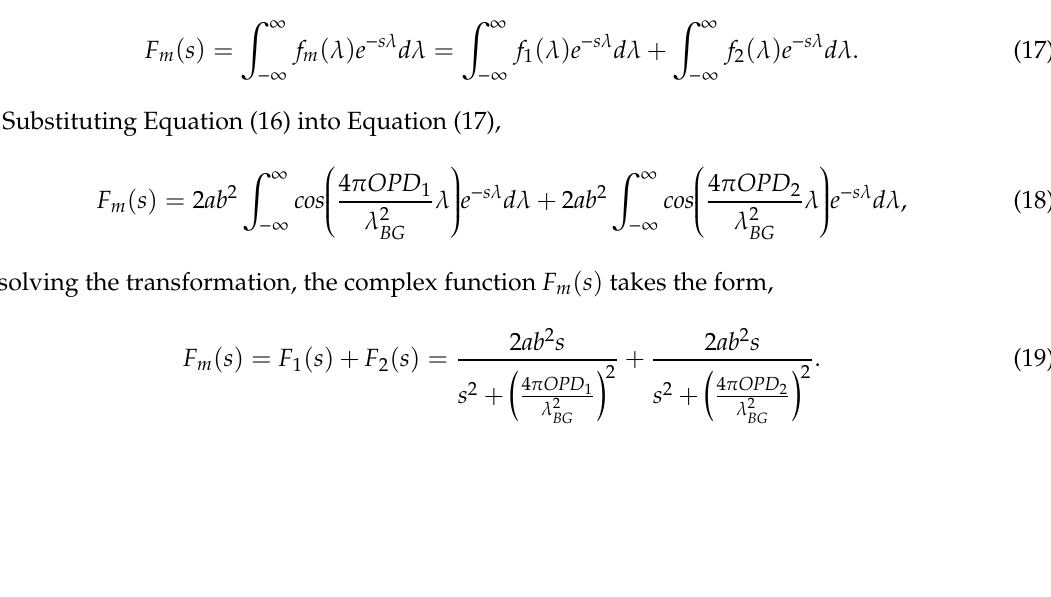
( λ ) ; ( b ) function f ( λ ) 2 1